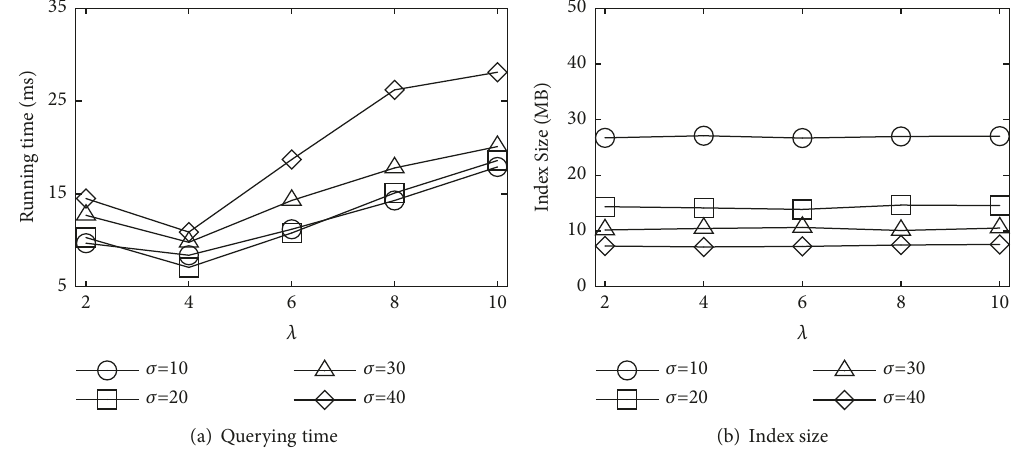
Figure 11: Impact of 𝜆 and 𝜎